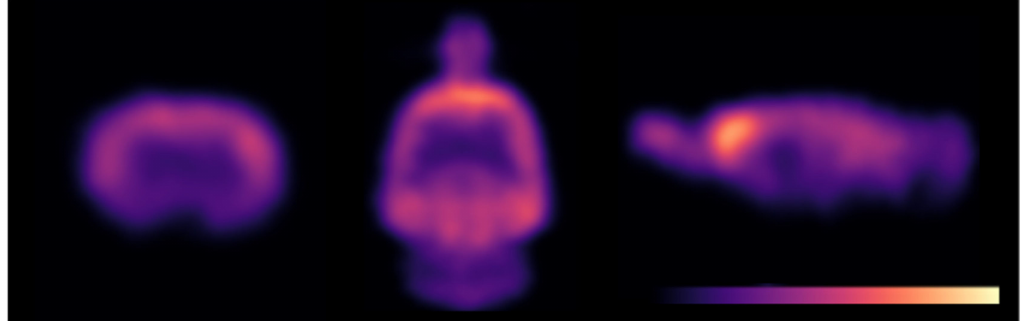
Figure 5. Representative image of [ 18 F]flumazenil 1 uptake.